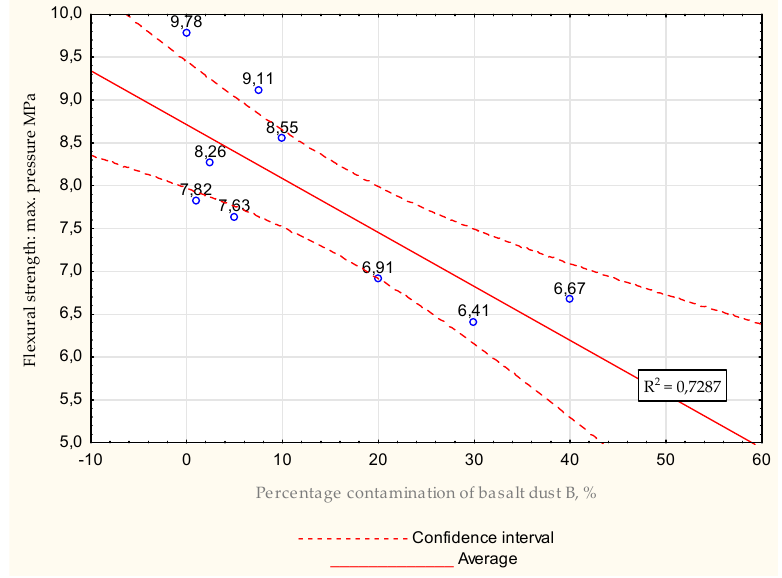
Figure 28. Average values obtained during flexural strength tests after 28 days for water − mix ratio = 0.5, maximal pressure.